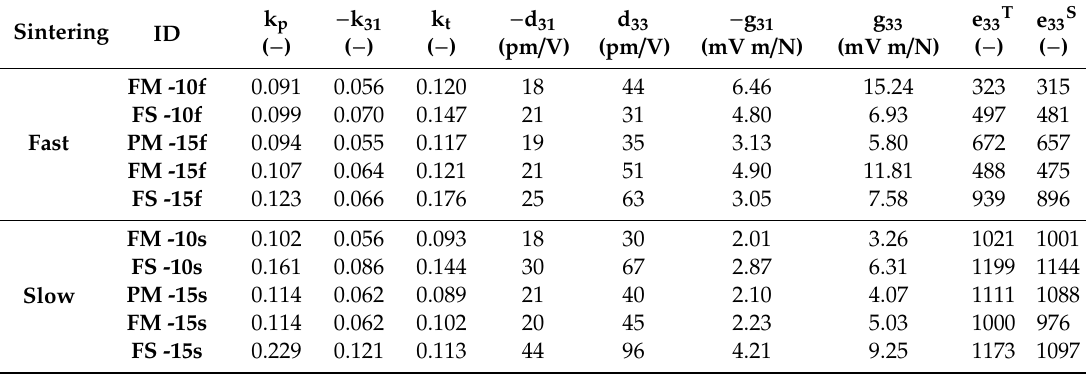
Table 2. Electromechanical conversion factors k p (planar), k 31 and k t (thickness); piezoelectric constants d 31 and d 33 ; voltage constants g 31 and g 33 and low-frequency dielectric